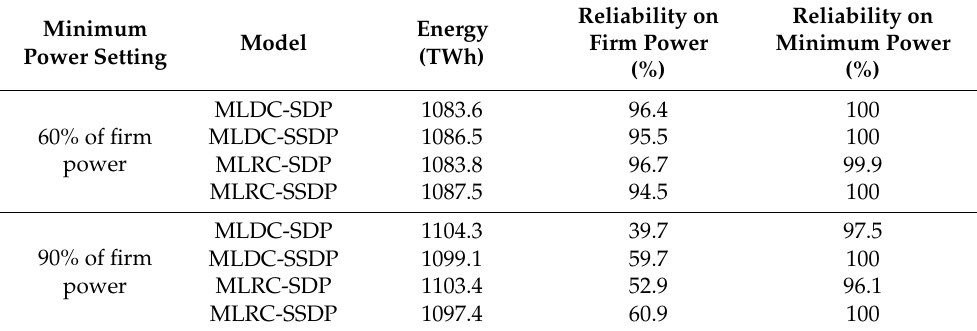
Table 2. Computing results for single reservoir of